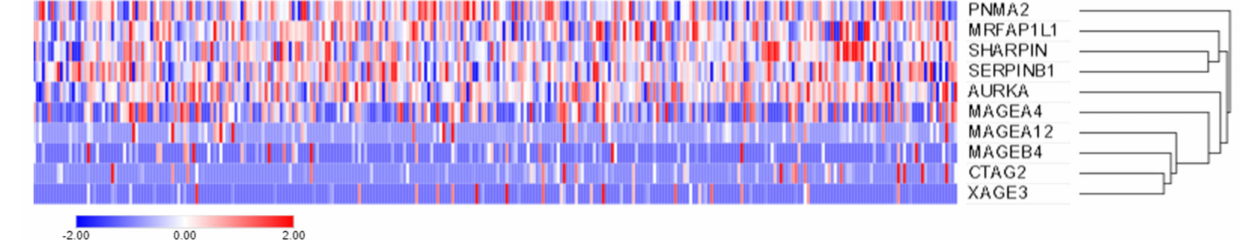
Figure 3. Gene expression of candidate tumor-associated and cancer-testis antigens in a separate ovarian cancer TCGA dataset. Heat map representing the hierarchical clustering using Euclidean distance of 307 ovarian serous cystadenocarcino- mas (TCGA dataset) based on CTAG2, MAGEB4, SHARPIN, MAGEA12, MAGEA4, MRFAP1L1, PNMA2, AURKA, SERPINB1 and XAGE3 mRNA expression. mRNA expression is shown as Z-scores (RNA Seq V2 RSEM) with scale bar set from − 2 (blue) to 2